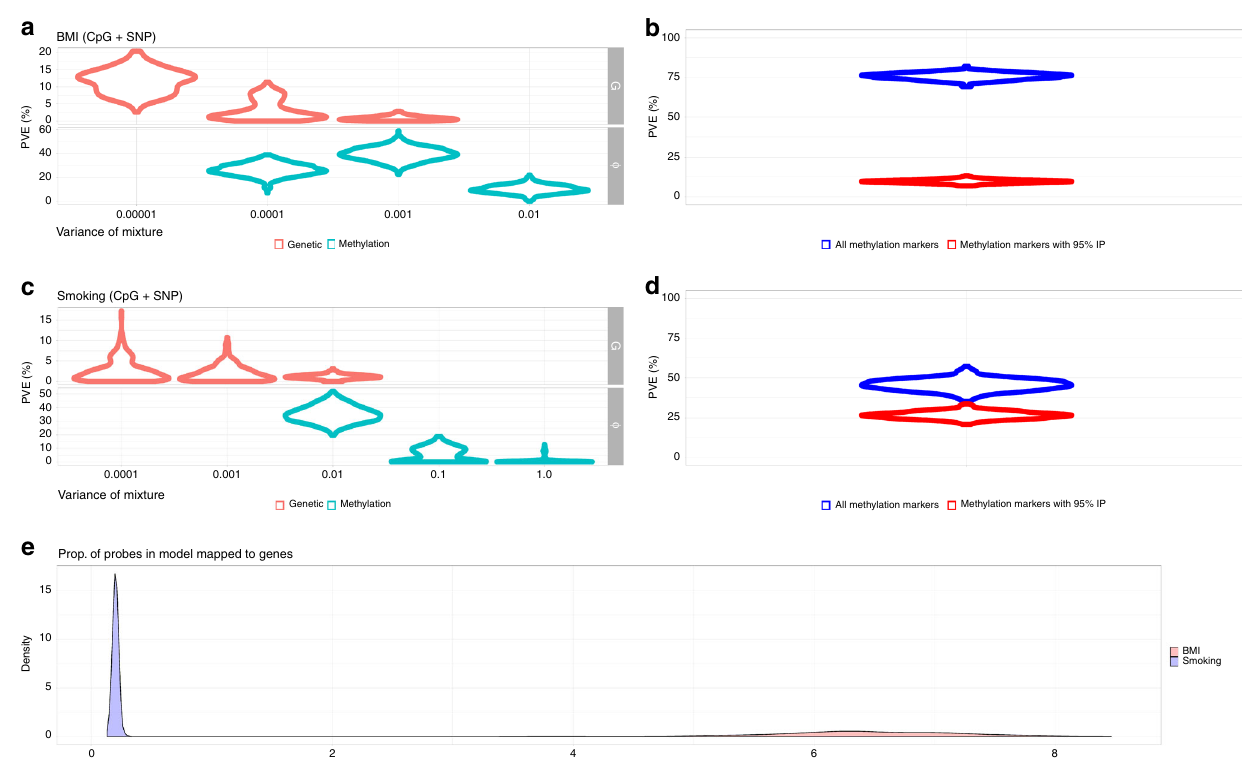
Fig. 2 Biomarker architecture. Boxplot representing distribution of scores, the line in the middle represents the median, lower bound of the box represents the fi rst quartile, upper bound represents the third quartile, whiskers represent up to 1.5 times the interquartile range from the top or bottom, respectively a Phenotypic variance of BMI attributable to the three mixtures for single-nucleotide polymorphism markers (SNP; genetic) and methylation probes, with mixture variances (0.00001, 0.0001, 0.001) and (0.0001, 0.001, 0.01), respectively for BMI, and (0.0001, 0.001, 0.01), and (0.01, 0.1, 1.0) for smoking. b For BMI, the phenotypic variance captured by all markers in the model (blue) and for the markers with 95% posterior inclusion probability (IP; red) is shown. c For cigarette consumption, the phenotypic variance captured by the mixtures for the SNPs and methylation probes, with same mixture-speci fi c variances as for BMI. d Phenotypic variance captured by all markers in the model (blue) and by the markers with 95% IP for cigarette consumption. e Distribution of proportion of all methylation probes in model for BMI (red) and smoking